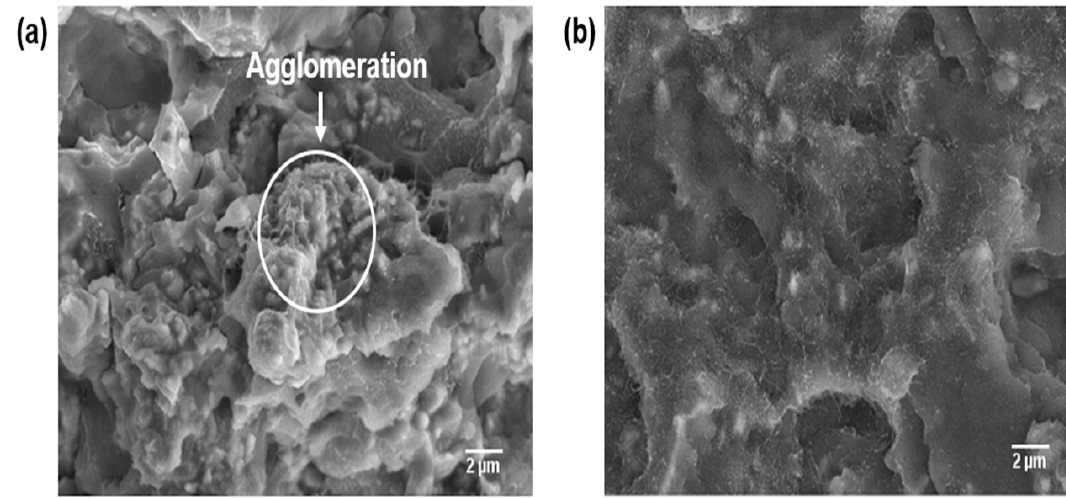
Figure 10. FE-SEM images of the ( a ) PPSHP1AlN20; and ( b ) PPSHP1sAlN20. Polymers 2017 , 9 , 452